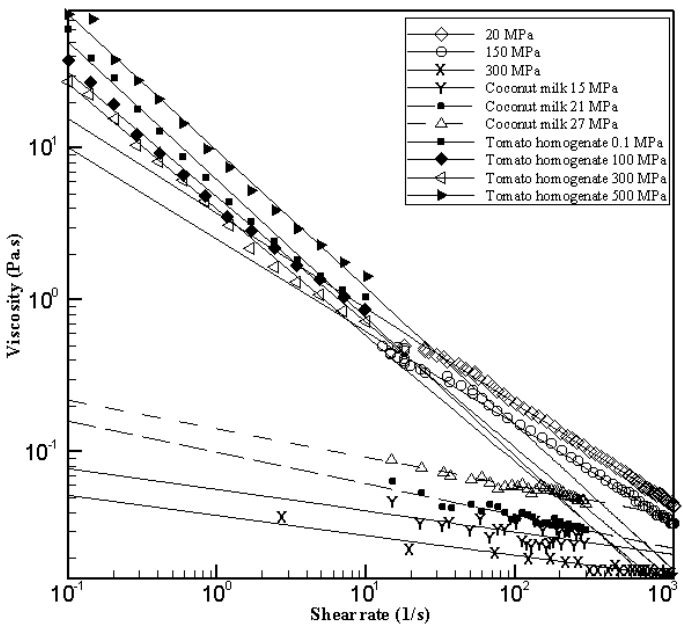
Figure 9: Effect of homogenizing pressure on rheological properties of emulsions: viscosity vs. shear rate of 50% mass fraction of O/W emulsions homogenized at three different pressures: 20, 150 and 300 MPa, the coconut milk at three different pressures: 15, 21 and 27 MPa and tomato homogenate after treatment for 15 min at 30 ºC combined with four different pressures: 0.1, 100, 300 and 500 MPa [11, 24, 36]. With high pressure, lowest viscosity can be achieved. This is due to in the homogenising valve, it has high shear stress and energy density, where at high pressure, the flocculation droplet will not be able to occur at the homogenizer exit, so a smaller and fine droplet size can be produced. The energy can be expressed as eq (4) and eq (5). As can be seen from Figure 9, with high pressure, lowest viscosity can be achieved. Figure 9 shows the plot of homogenised coconut milk which contains apparent viscosity against shear rate at five levels pressure different [24]. Power law model was used on the samples to define the rheological behaviour [24]. The model was defined in the eq (6) where τ is the shear stress, γ is the shear rate, K is the consistency index (Pa s n ) and n is the flow behaviour index.